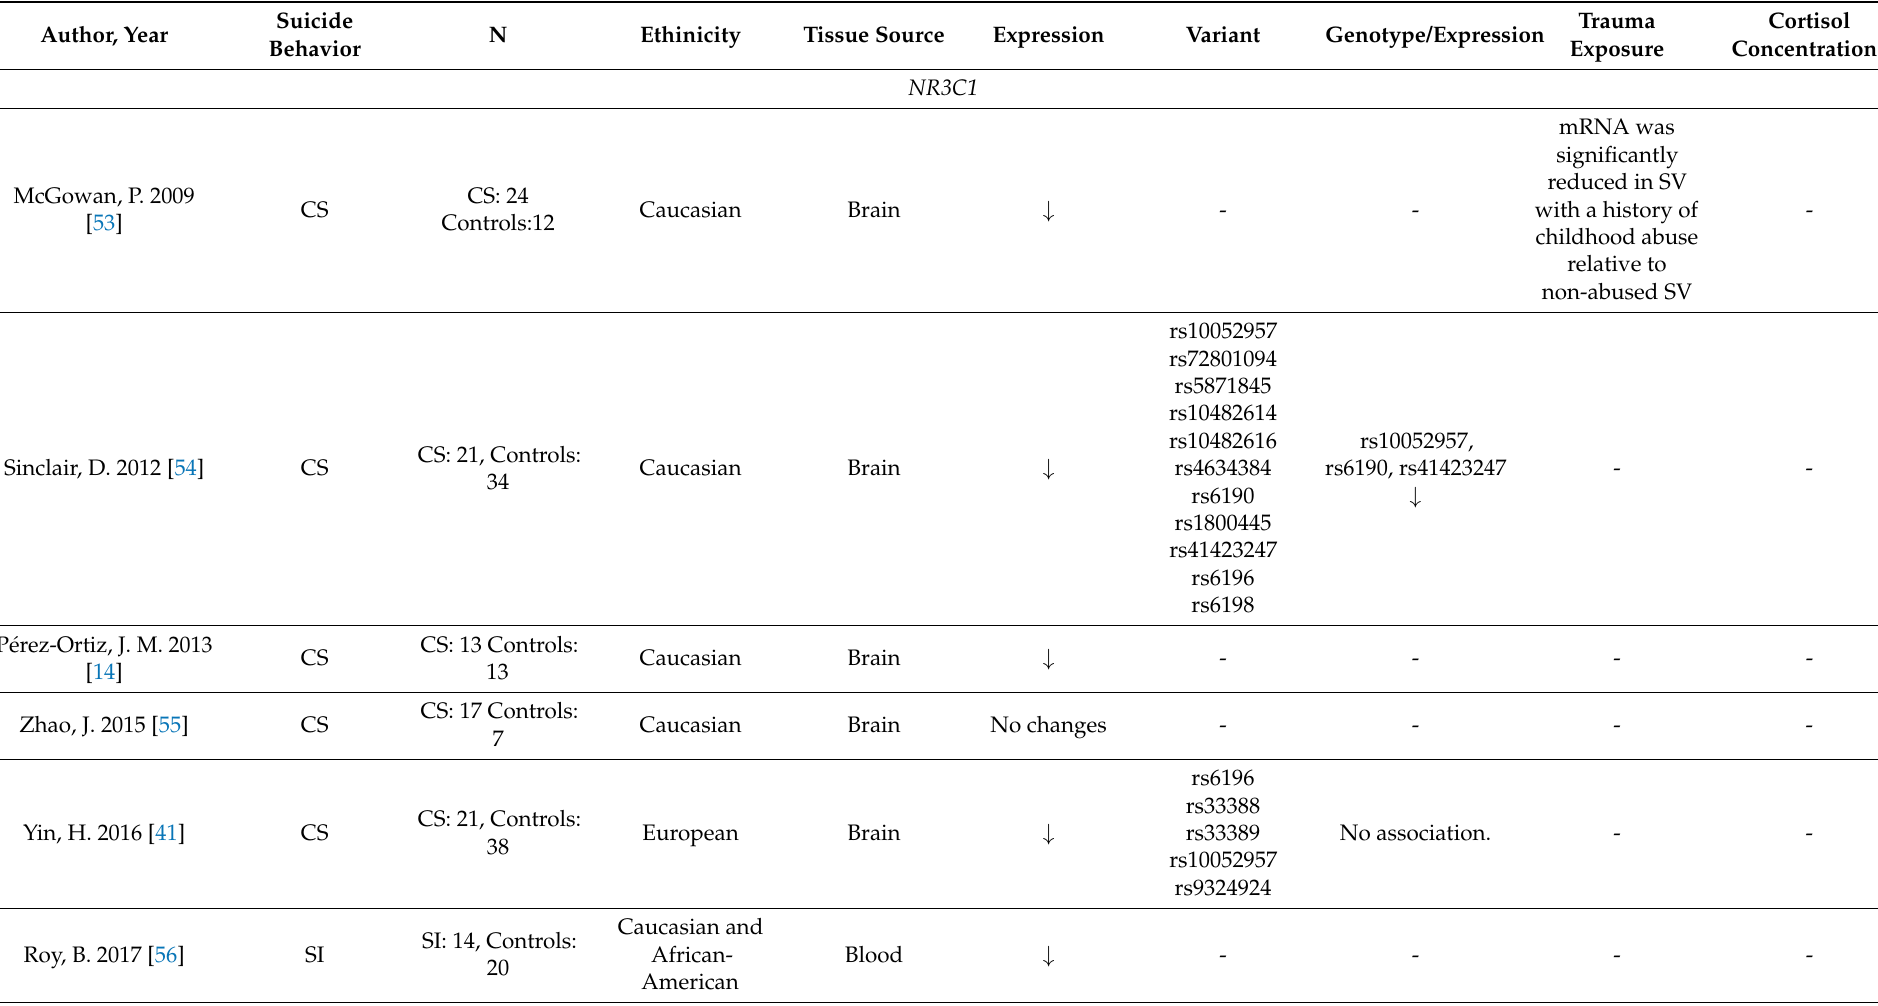
Table 2. Characteristics of the included publications that evaluated HPA genes expression (mRNA) in the pathogenesis of suicide